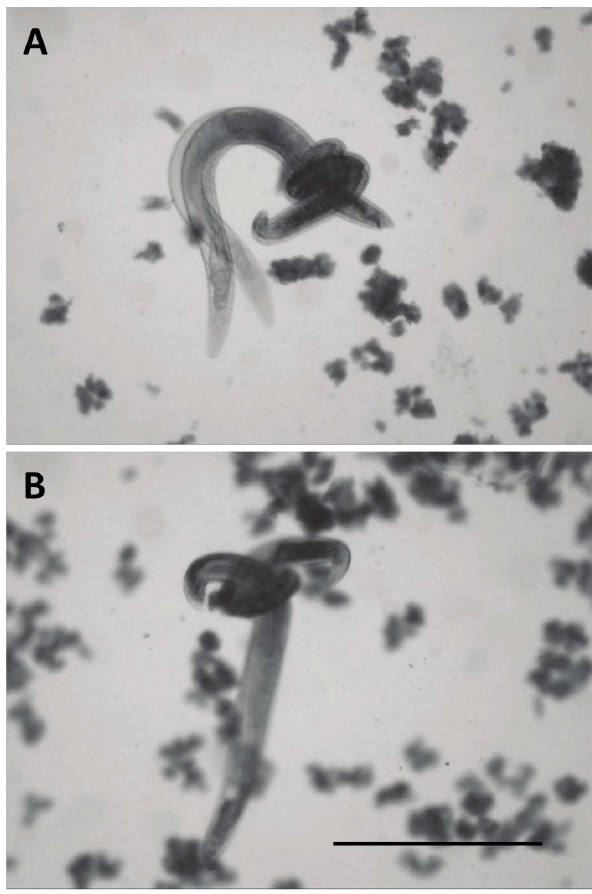
Figure 2. Fighting nematodes. Fighting in Steinernema longicaudum in a drop of insect haemolymph A . A male wrapped around the tail end of another male (the victim). The victim is moving rapidly at this stage, resulting in blurring of the image. B . The same pair ten minutes later. Here, the victim has slowed movement and is paralysed. Scale bar: 1 mm.